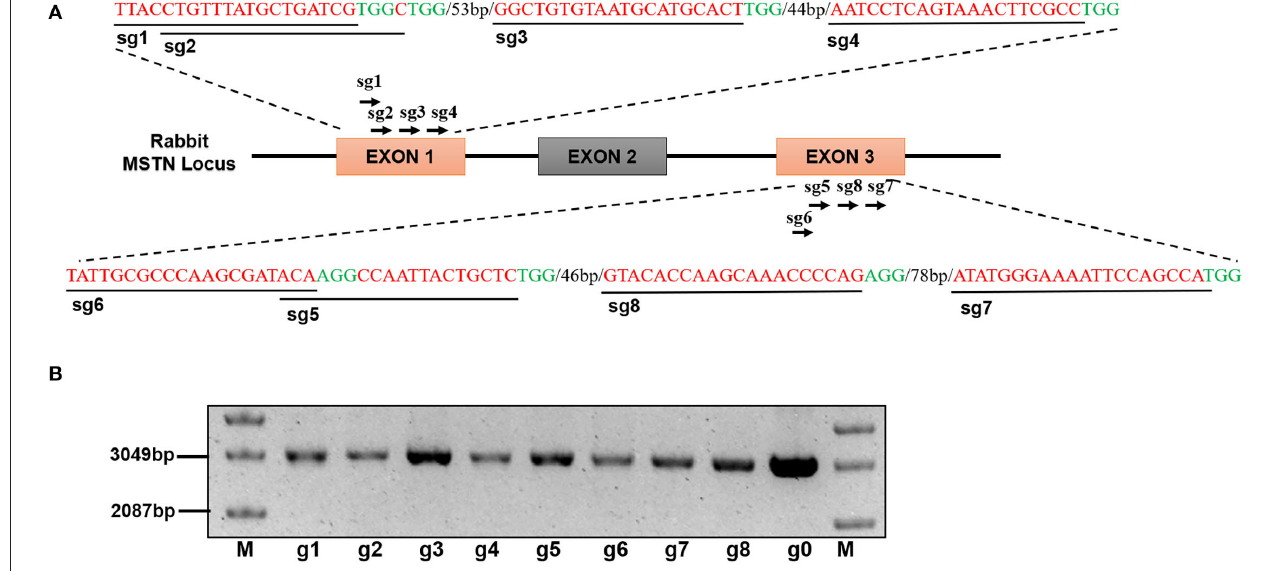
FIGURE 1 | (A) Design and construction of sgRNA Schematic diagram of sgRNA targeting site in the rabbit MSTN gene locus. (B) Electropherogram of eight sgRNA vectors, M: Supercoiled DNA Ladder Marker, g1-g8 refer to phU6-gRNA-Sg1to phU6-gRNA-Sg8 (The picture has been cropped).